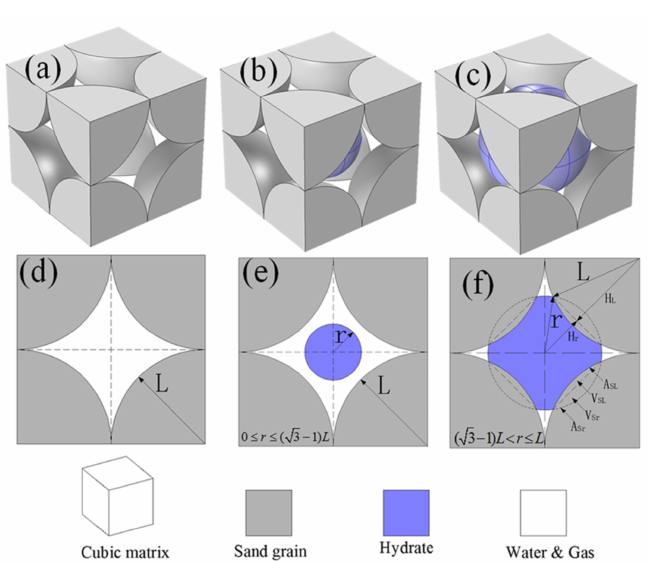
Figure 11. The simple cubic sphere pack model unit of hydrate occupying pore centers reprinted from [56] with permission from Elsevier. ( a ) The simple cubic sphere pack model; ( b , c ) the simple cubic sphere pack model with hydrate growth; ( d ) the front view of the sand grain and the pore space without hydrate; ( e ) the front view of hydrate occupying pore center; ( f ) the front view of the cubic matrix when the grains intersect with